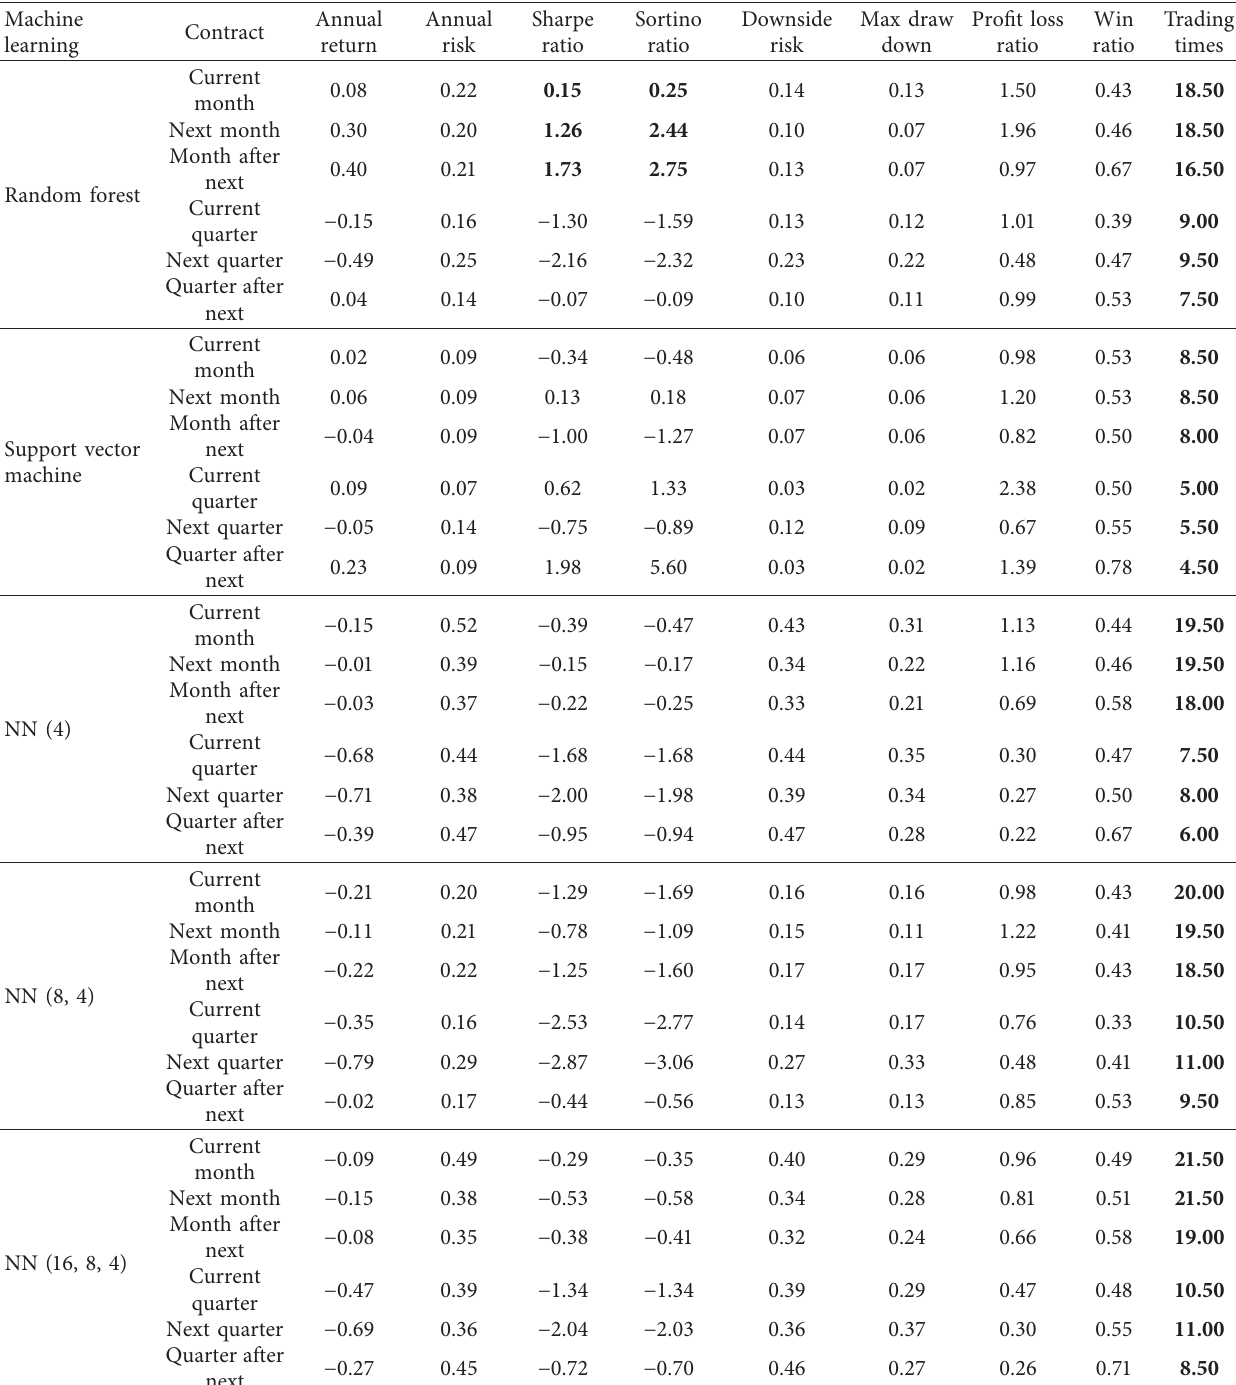
Table 12: Option strategy of predicting the rise and fall of volatility by threshold (use 12 features M2, threshold � 0.5). Machine